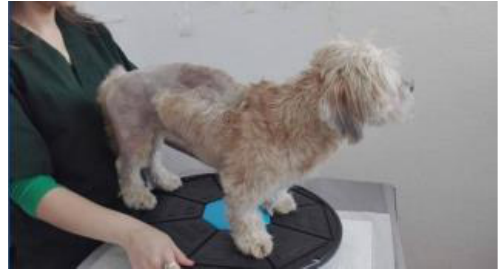
Figure 6. Balancing platform exercises.